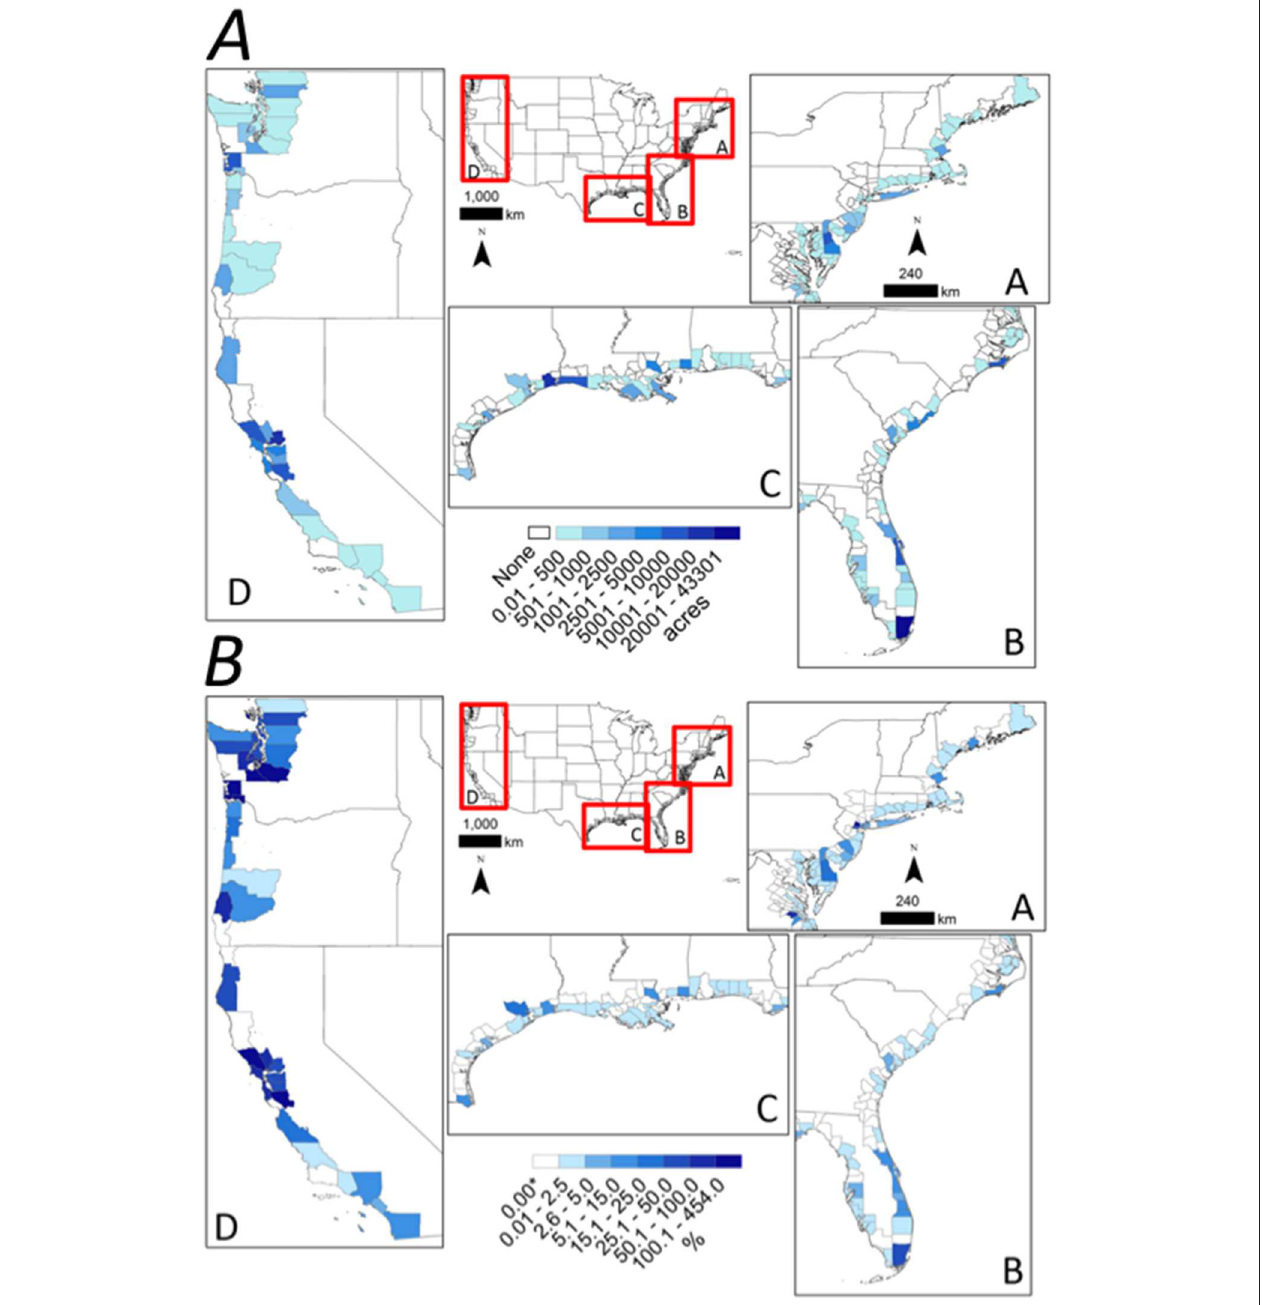
FIGURE 4 | National maps with inset panels showing coastal county-level variation in voluntary estuarine wetland restoration efforts [cumulative acreage (A) and % of 1996 estuarine wetland area (B) ] along the (A) Northeastern coastline, (B) Southeastern coastline and gulf coast of Florida, (C) Gulf of Mexico coastline, and (D) Pacific coastline of the conterminous United